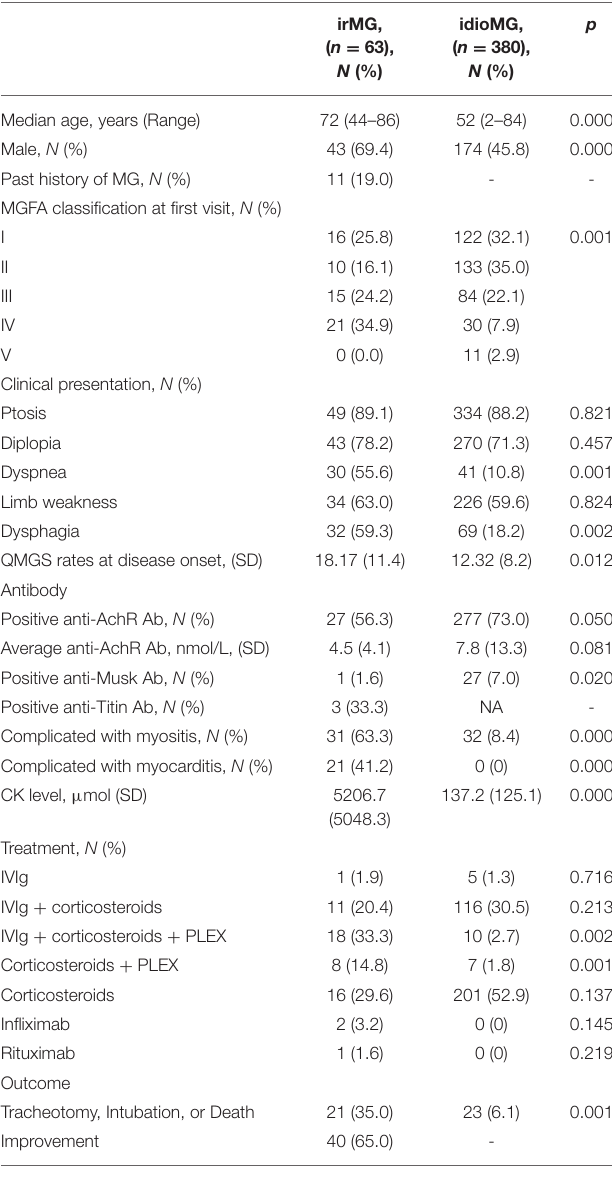
TABLE 1 | Demographic and baseline characteristics of patients. TABLE 2 | irMG characteristics and